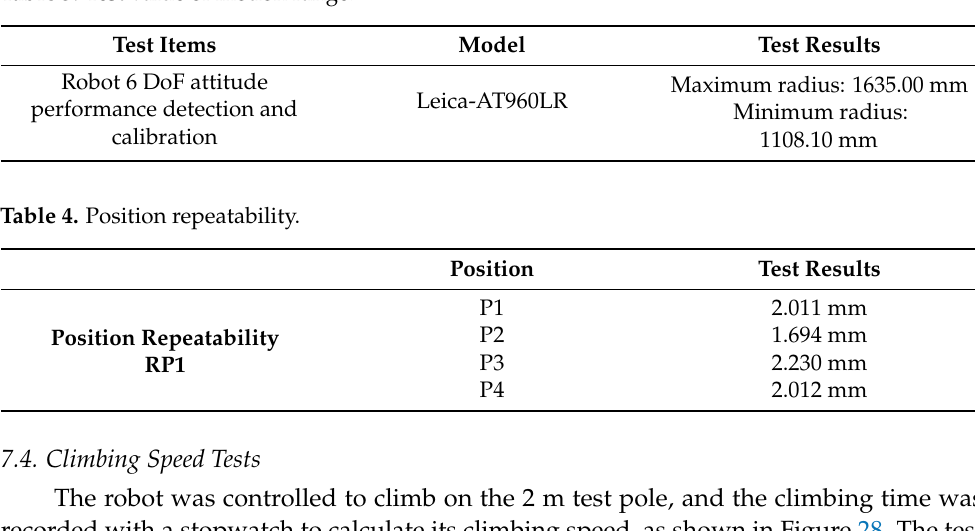
Figure 27. Test of range motion. ( a ) Test scenario, ( b ) equivalent manipulator, ( c ) motion range of manipulator. Table 3. Test value of motion range.